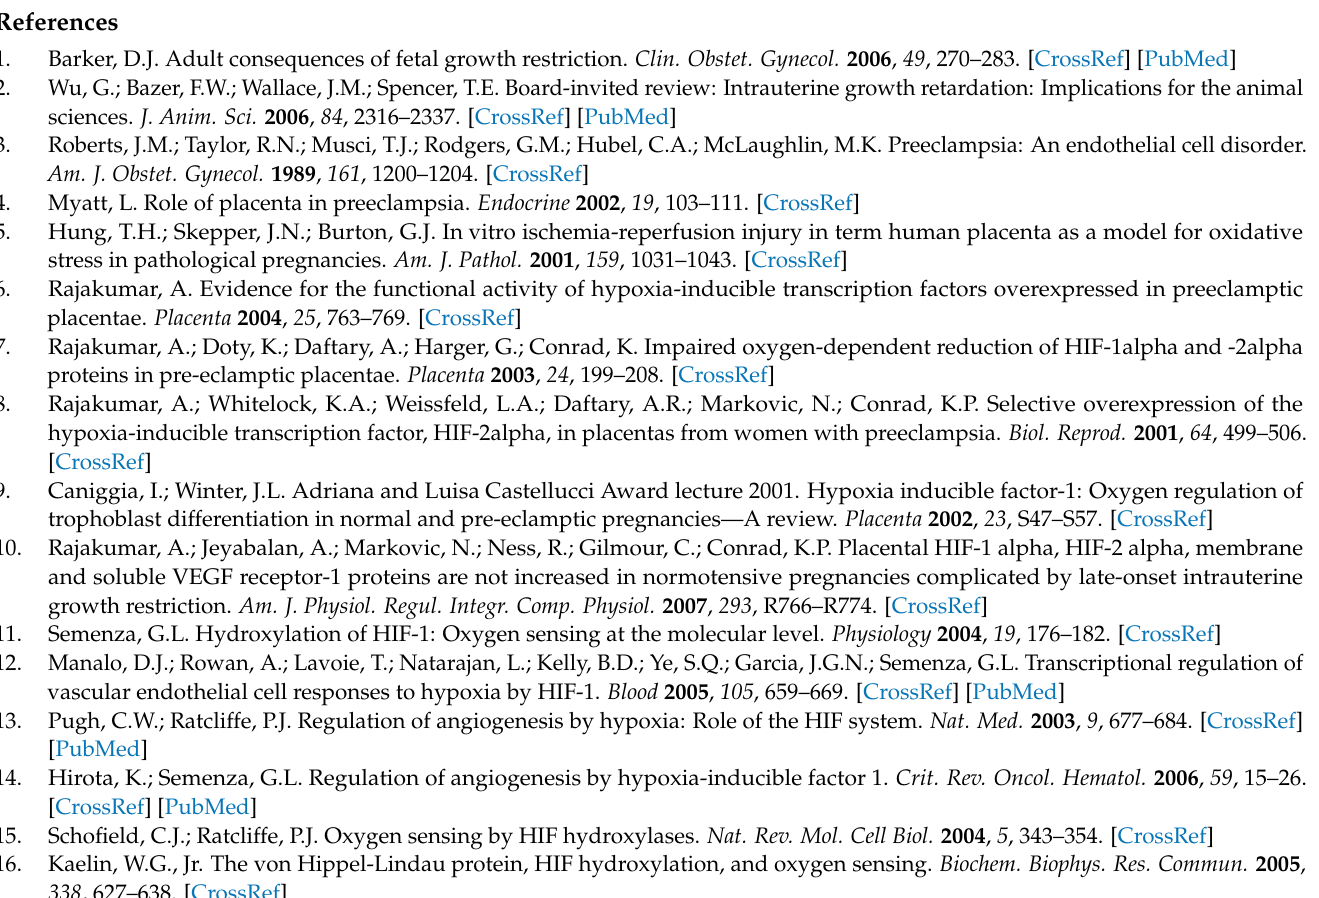
Table outlines sense (S) and anti-sense (AS) primers used, annealing temperatures, Mg 2+ concentrations, product lengths, and cycle numbers for PCR analysis of the genes